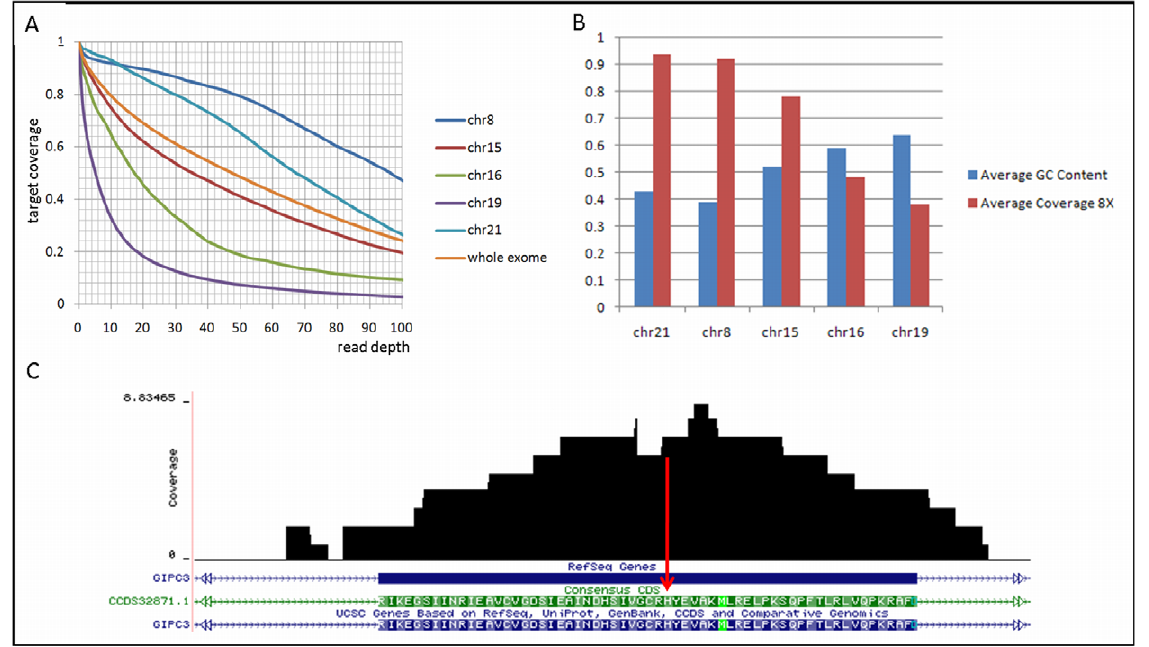
Figure 2. Coverage of autozygous regions with whole exome sequencing. (A) The exome coverage of the five longest autozygous regions. The plot shows the fraction of on-target coverage (Y-axis) and the read depth (X-axis) for the following specified regions. (B) Average coverage at minimum 8 6 and GC content of five autozygous regions. (C) Coverage of exon 3 in GIPC3 . Red arrow indicates mutation point.